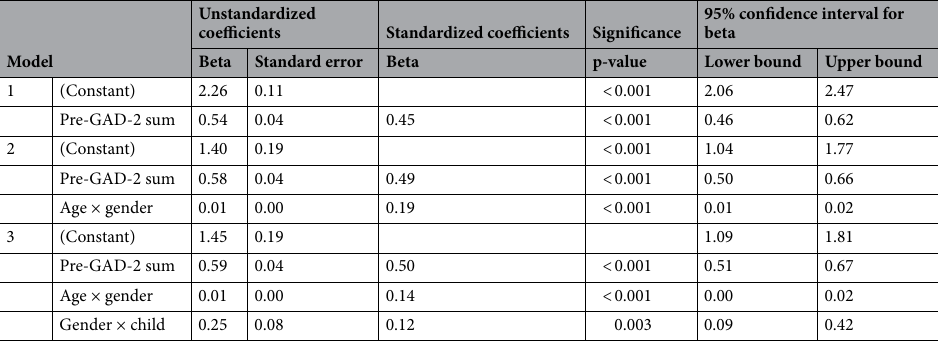
Table 3. GAD-2 regression coefficients.